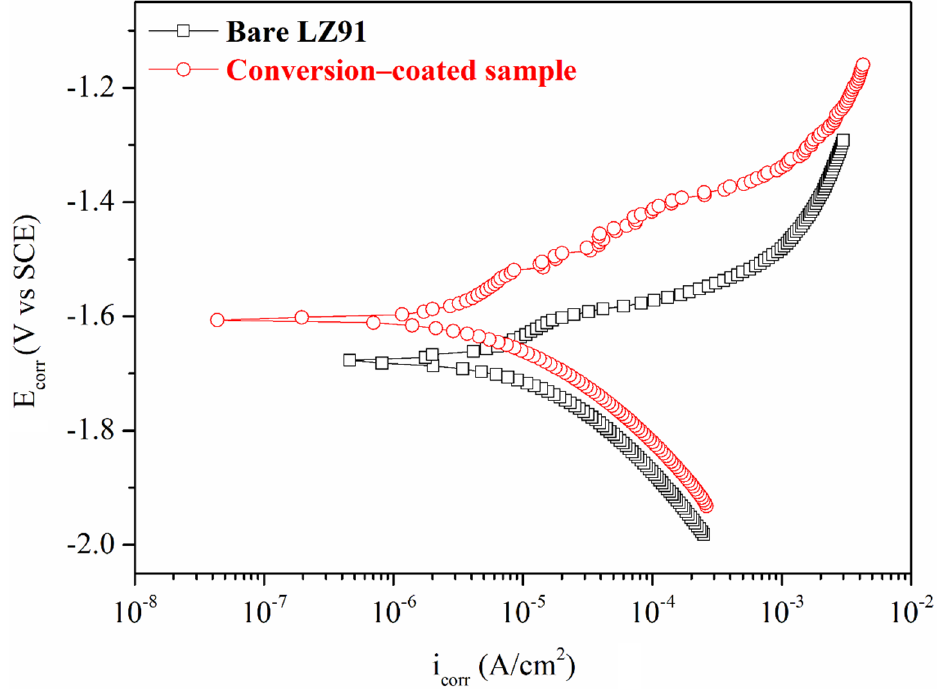
Figure 8. Potentiodynamic polarization curves for bare LZ91 and the conversion-coated sample using 3.5 wt.% NaCl solution.